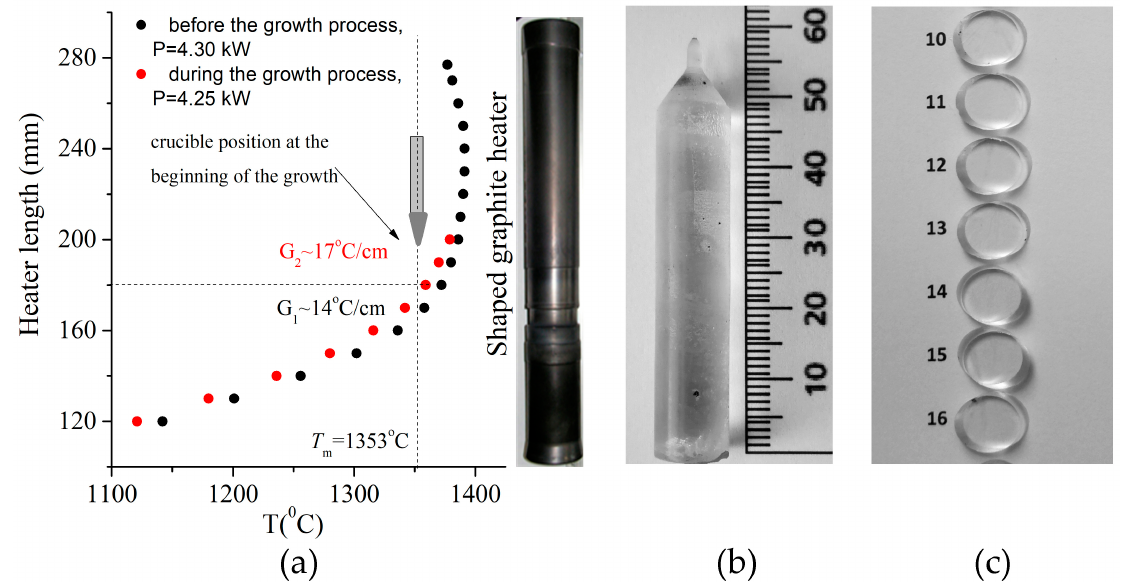
Figure 1. ( a ) Temperature distribution along the heater, measured before and during the crystal growth; ( b ) as-grown BaF 2 :0.5 mol% PbF 2 crystal; ( c ) some cleaved samples.